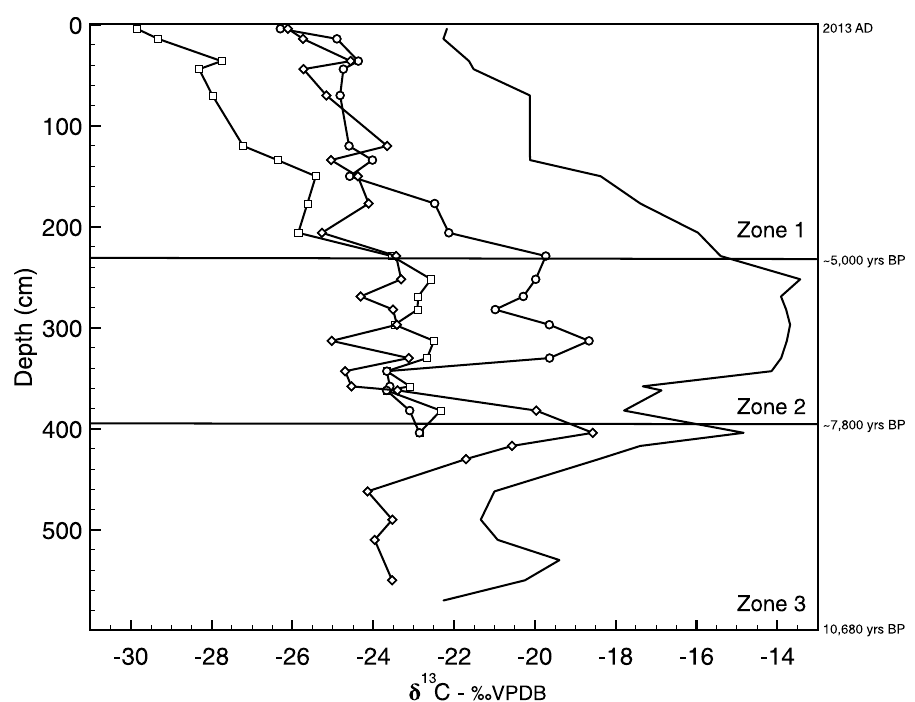
Fig 6. n -alkane isotopic variability. Carbon isotope variability in select n -alkane chain lengths in the Lake Harris core.